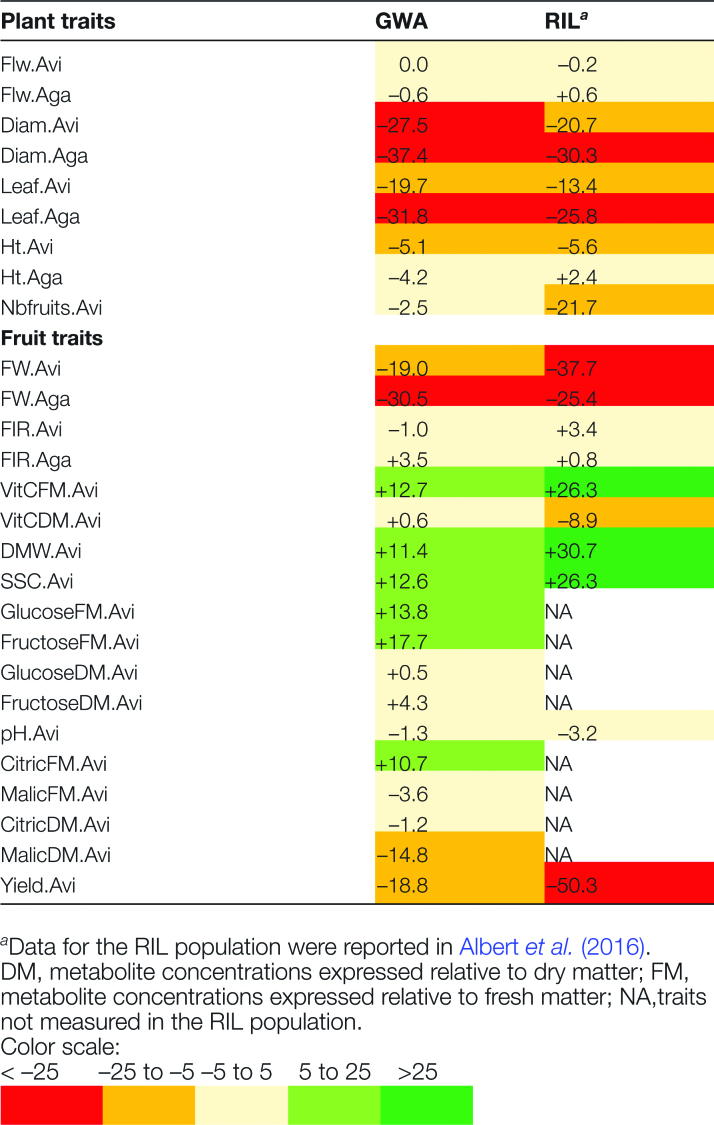
Average relative difference between control and drought conditions for the fruit and plant traits measured in the GWA and RIL populations (%)The average relative differences were computed as: (Mean Drought–Mean Control)/Mean Control.